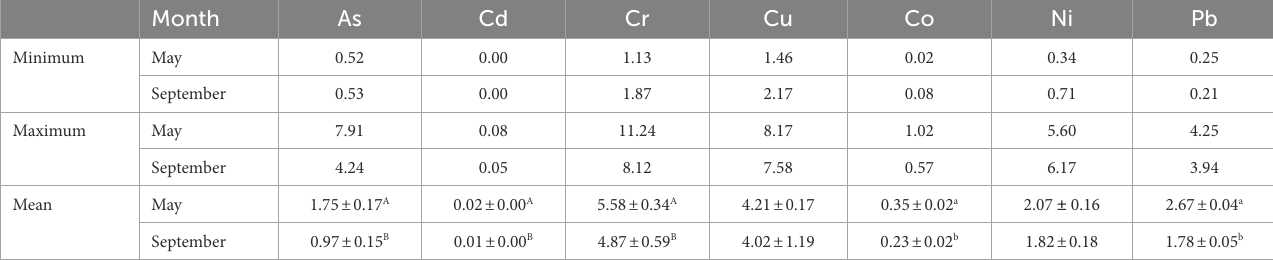
TABLE 2 Summary of heavy metal concentrations in grass in May and September (mg·kg − 1